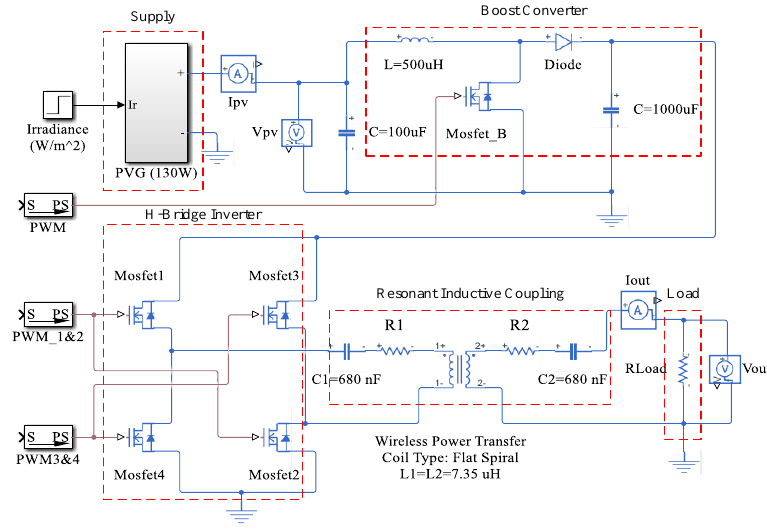
Figure 17. SIMULINK model of the proposed WPTS based on practical design. Table 7. Parameters of the complete WPTS.